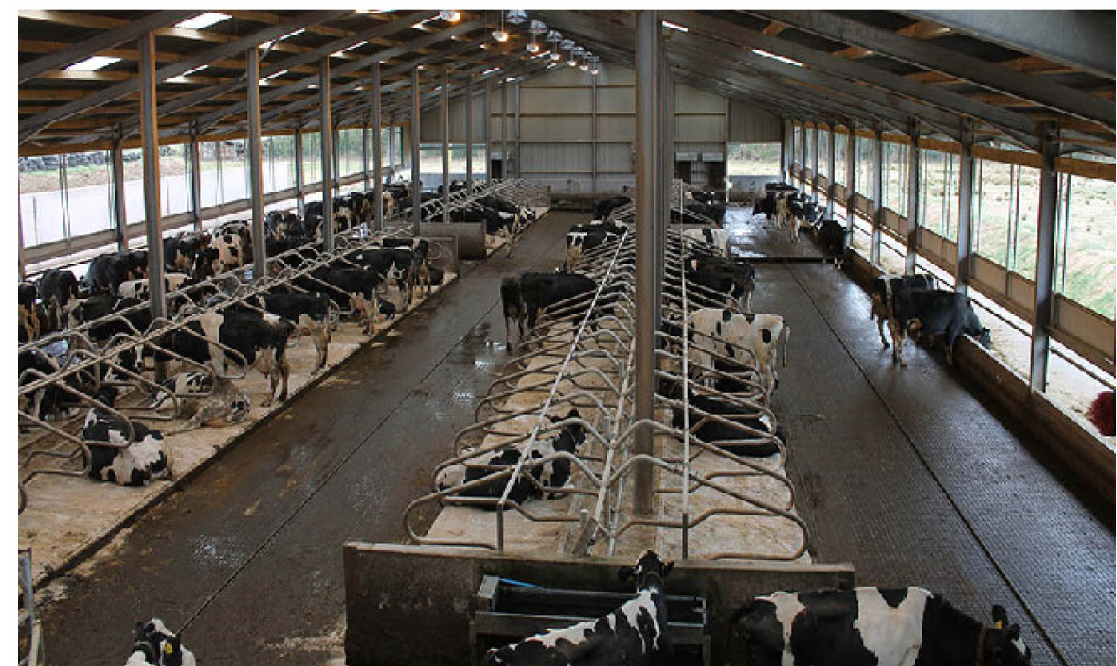
Figure 2. Free-stall barn with a self-cleaning floor (A. Poniewa˙z).